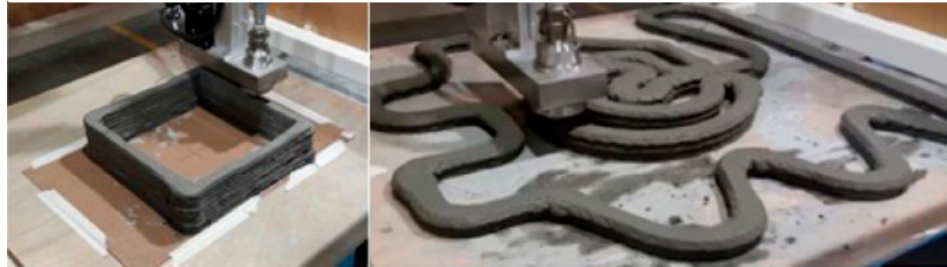
Figure 7. Additive Manufacturing as Walls 3D Manufacturing and Bricks 3D Manufacturing. (Reproduced with permission from: [16], Virtual and Physical Prototyping; published by Taylor & Francis Group, 2017) .